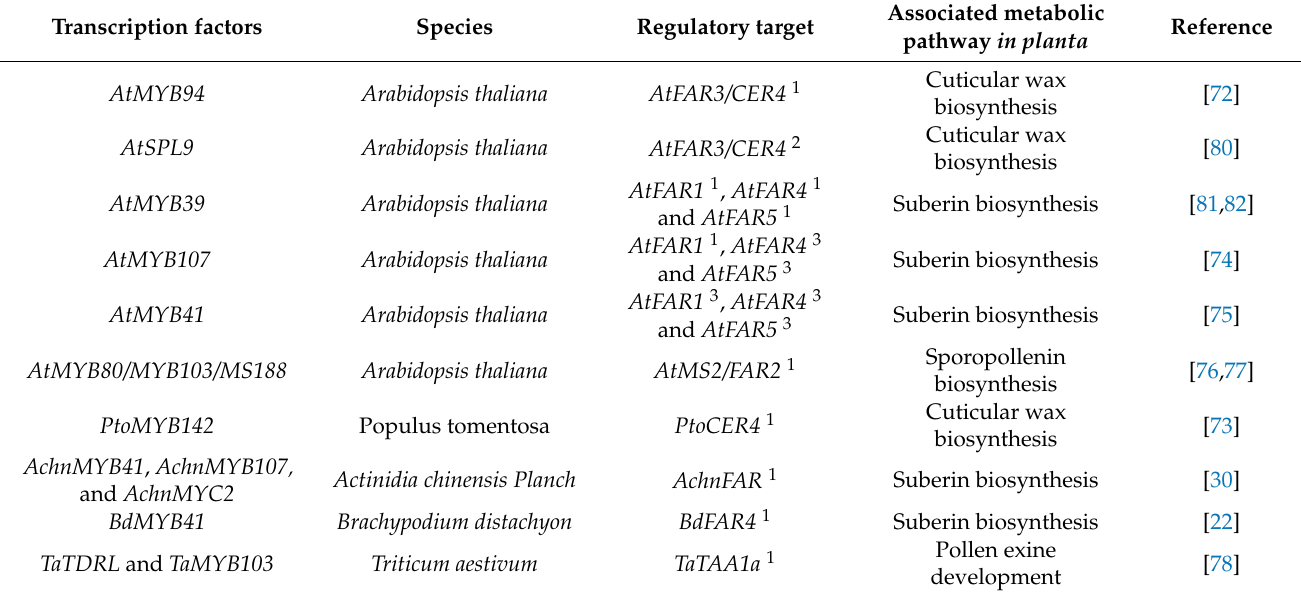
Table 2. Transcription factors associated with FARs